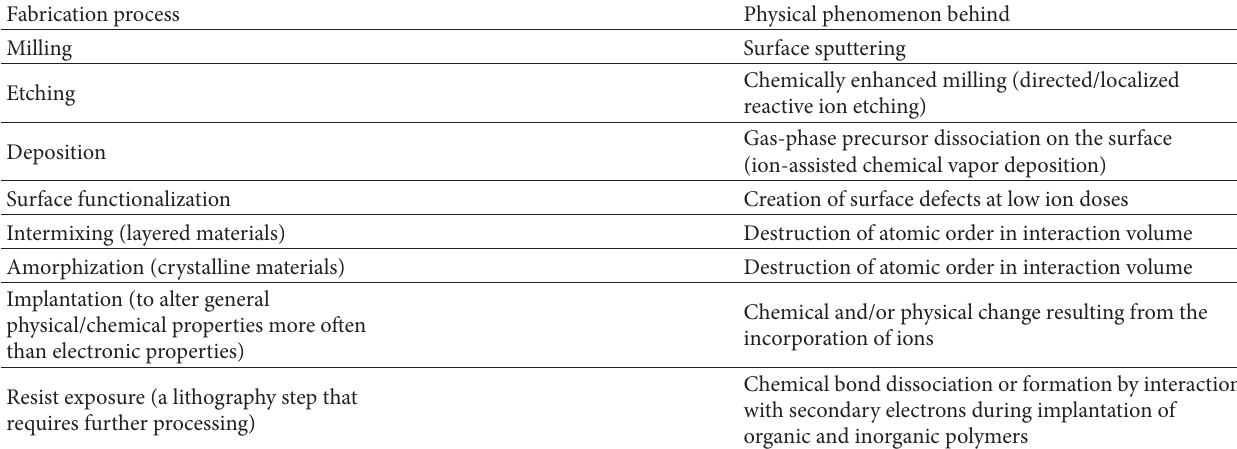
Table 1: Summary of fabrication processes with focused ion beams and the corresponding physical phenomenon behind